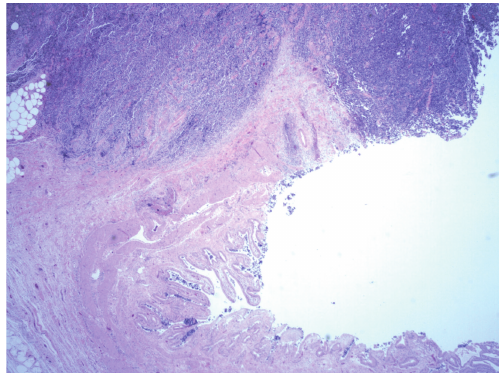
Figure 3: The tumor di ff usely infiltrates into the gallbladder wall and involves the mucosa. (HE) × 20.